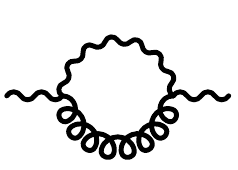
Figure 6. First-layer perturbation Figure 6. first-layer perturbation diagram